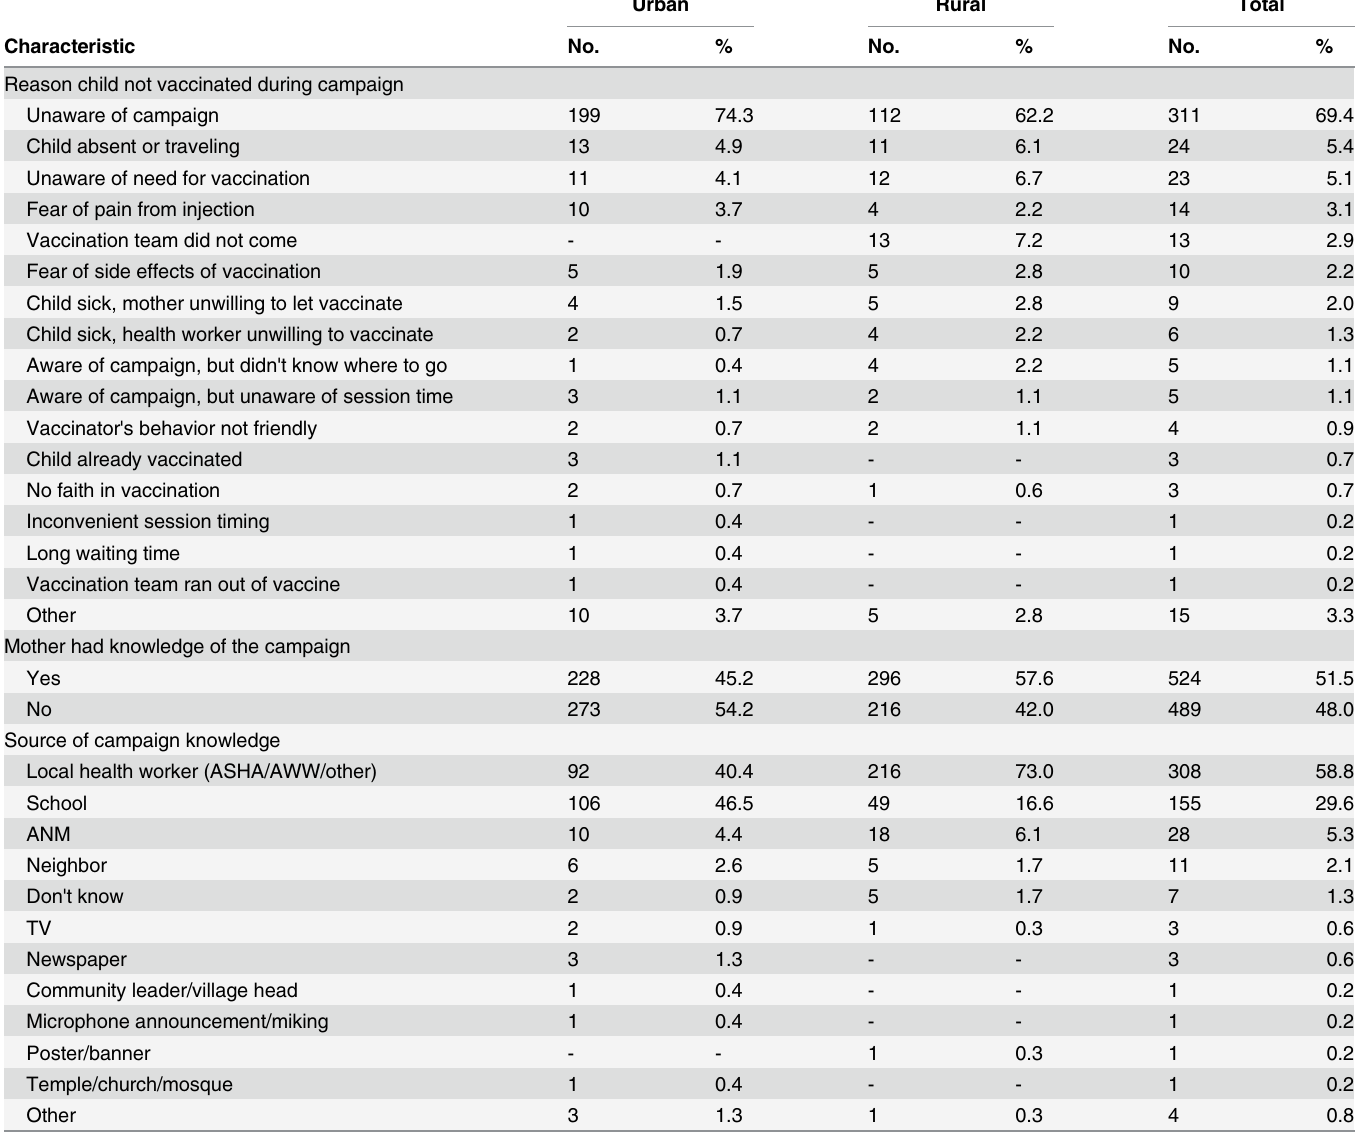
Table 4. Reasons for non-vaccination and awareness of the phase 2 measles vaccination campaign by urban and rural areas, Jharkhand,